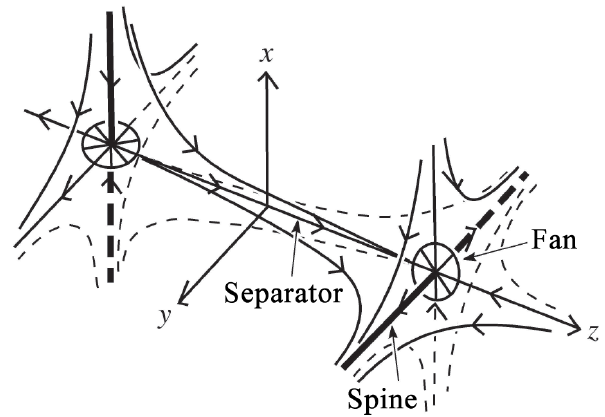
Figure 7. The magnetic structure near a separator lying along the z axis and joining one null point to